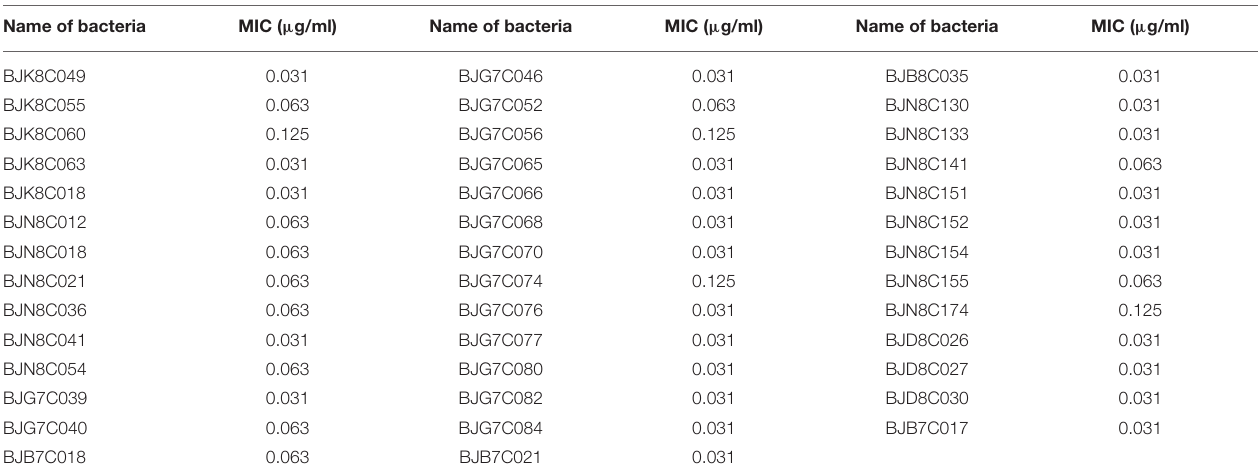
TABLE 1 | The MIC of rifaximin against 41 clinical